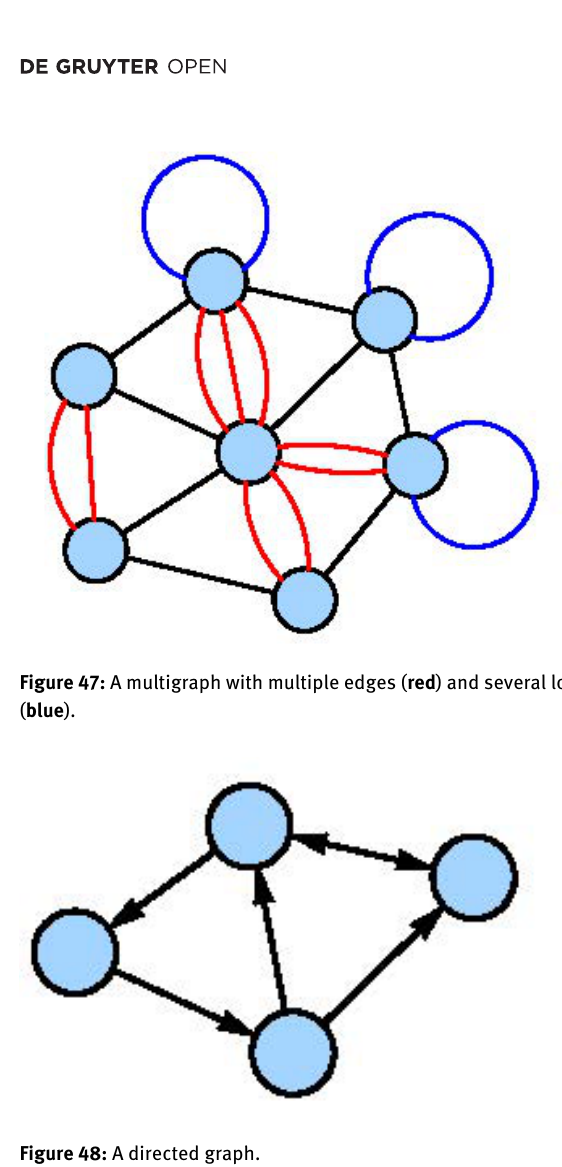
Figure 48: A directed graph.